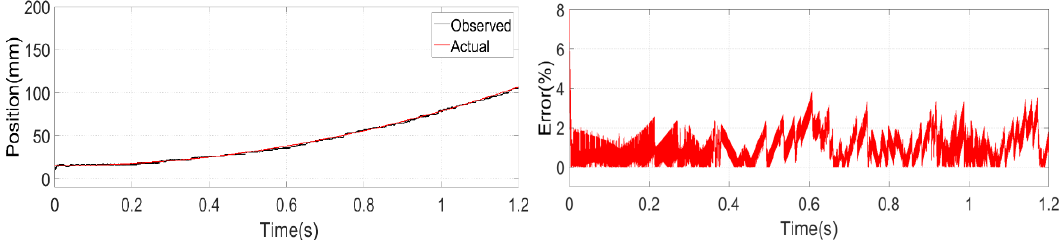
Figure 11. Position observation results at an injection voltage of 50V without filter.